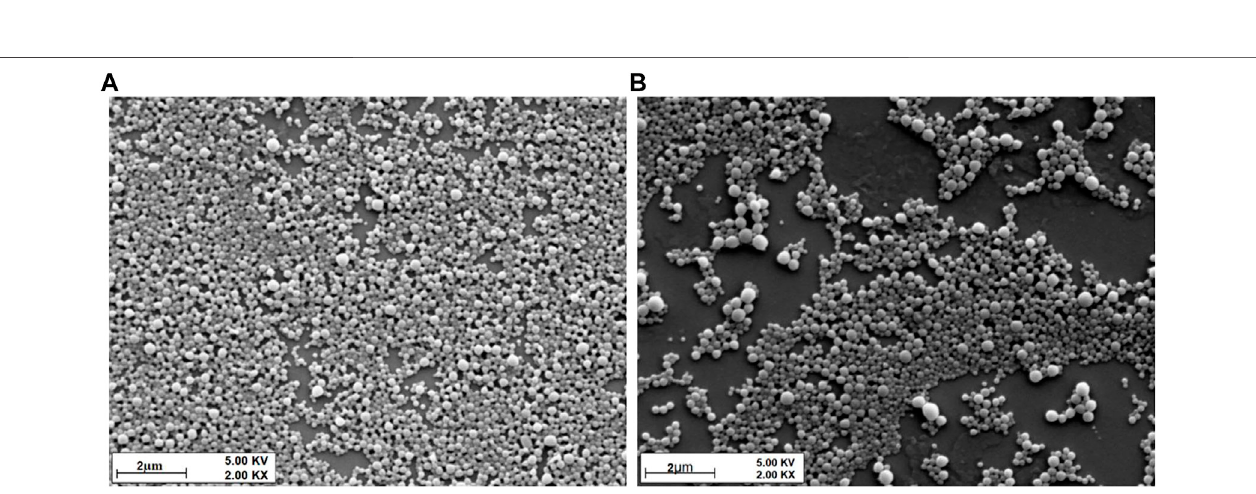
FIGURE 2 | SEM micrographs of (A) 12.5% keto and 87.5% PLGA NP formulation and (B) 100% keto and 0% PLGA formulation.